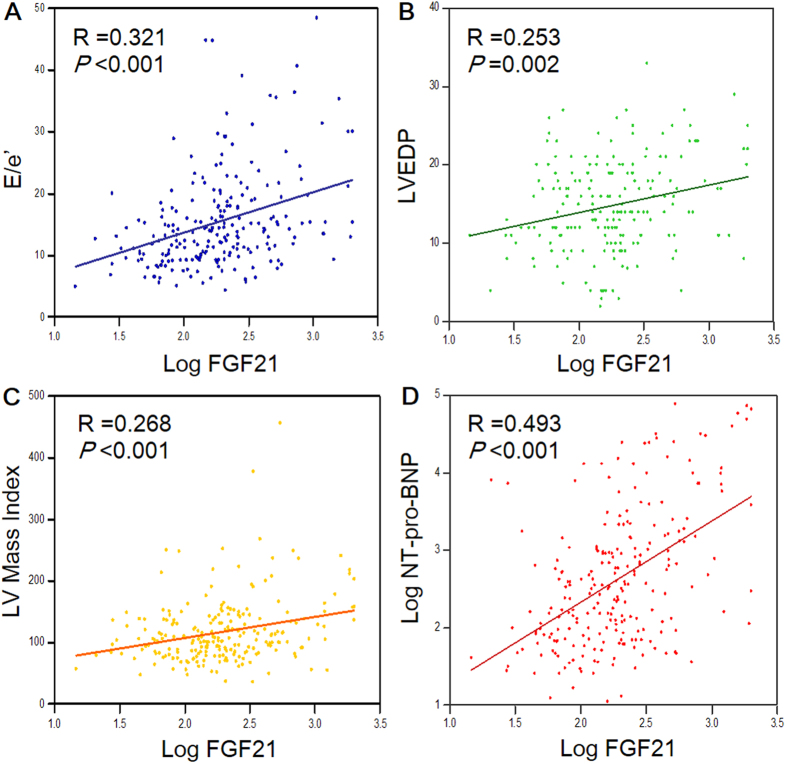
Scatter plots and correlation coefficients between log FGF21 and (1A) E/e’ ratio (1B) LVEDP level (1C) LV mass index (1D) log NT-pro-BNP values.Spearman’s correlation analysis was performed. (LV = left ventricular, LVEDP = left ventricular end-diastolic pressure).